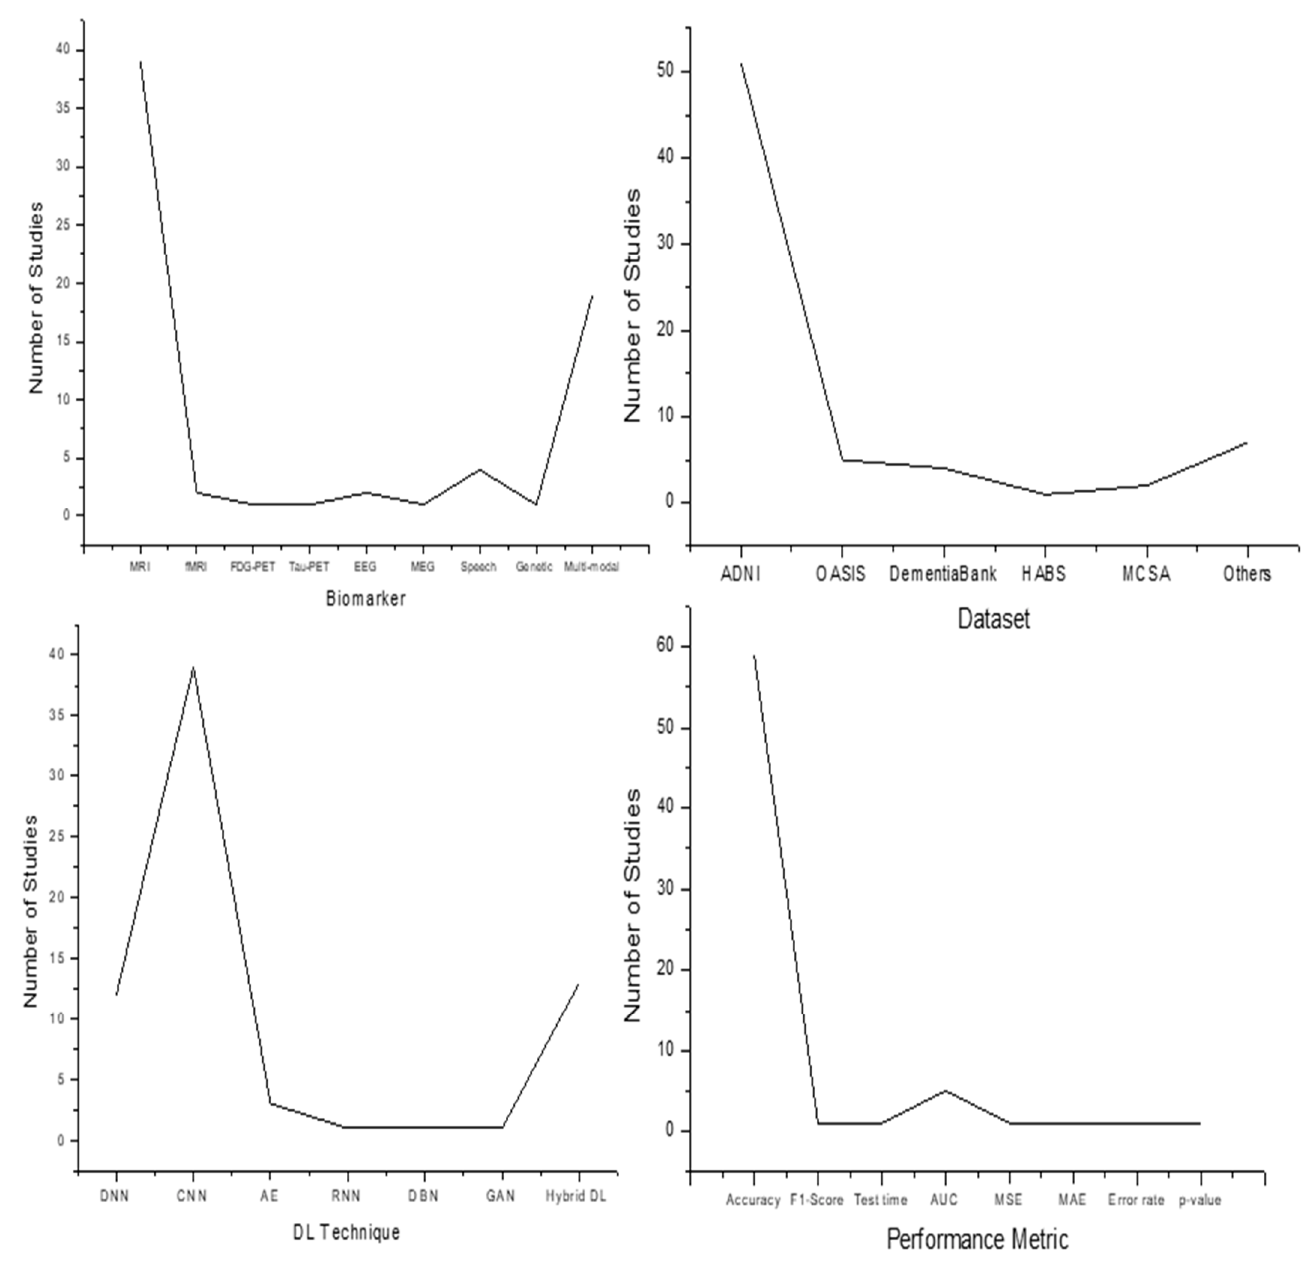
Figure 4. Number of studies versus biomarker, datasets, DL technique and performance metric.